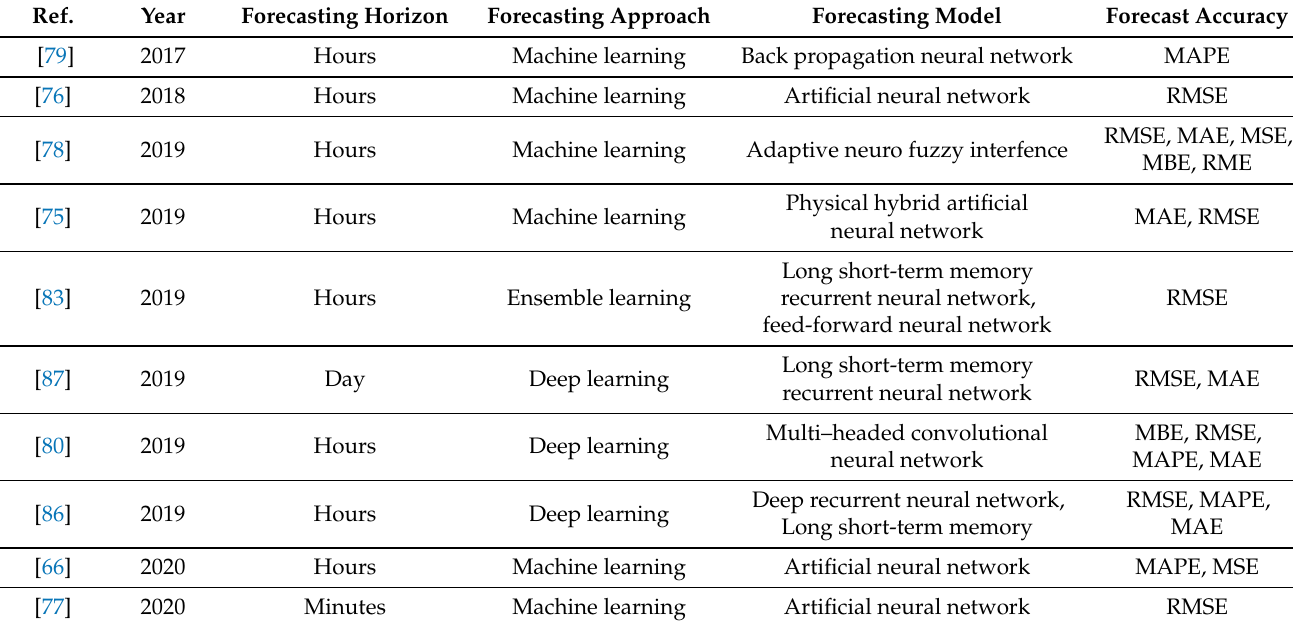
Table 3. Renewable energy resources forecasting: a comparison of approaches. Ref.